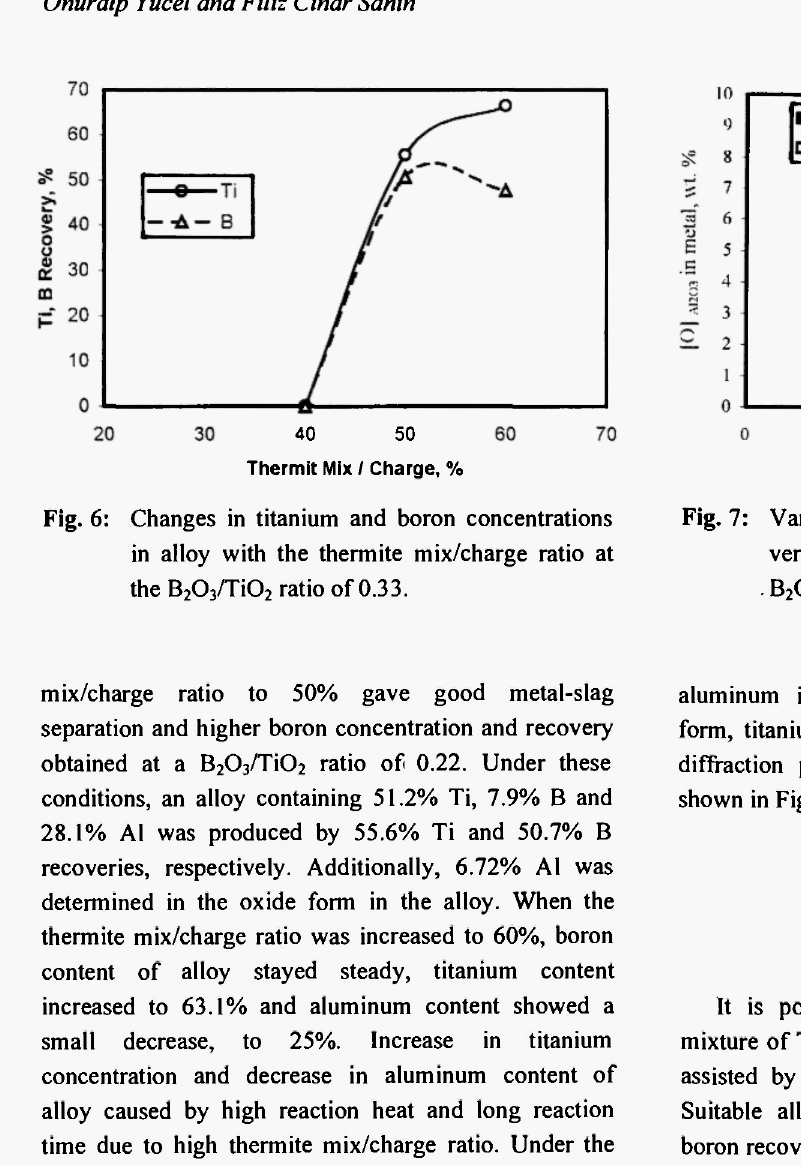
Fig. 7: Variation of oxygen concentration in alloy versus thermite mix/charge ratio for different . B2O3/T1O2